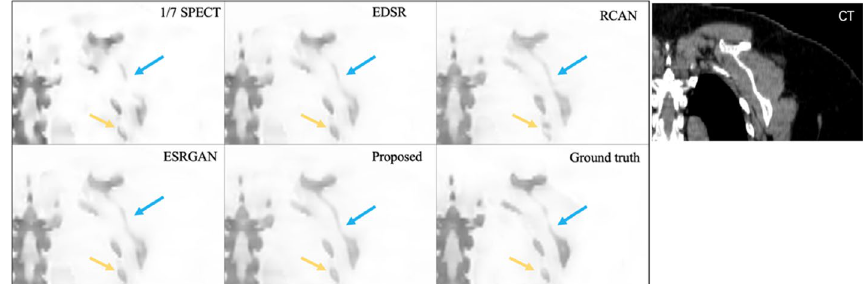
Fig. 4 Zoomed visual results of different methods on synthesizing standard SPECT from 1/7 SPECT. The results are zoomed images from the same case using 1/7 scan time constructed with the OSCG algorithm, enhanced by EDSR network, RCAN network, ESRGAN network, proposed U 2 ‑Net, respectively, and the standard SPECT